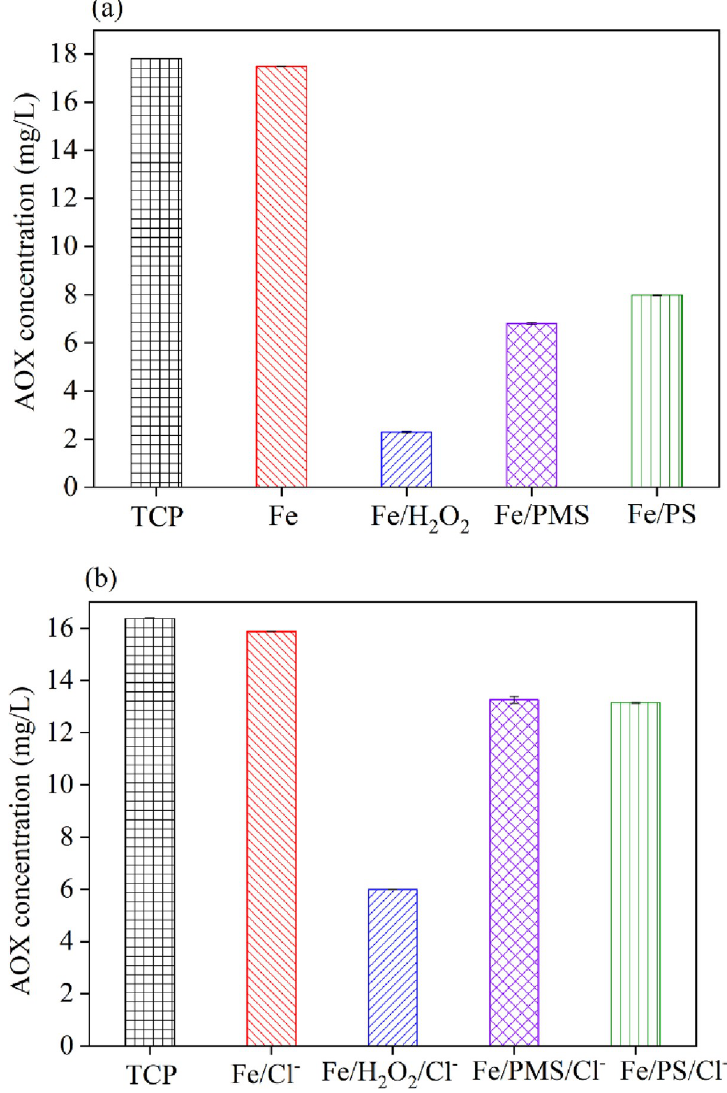
Fig 8. AOX concentration of 2,4,6-TCP degradation in four systems within 30 min. (a) without Cl - ; (b) with Cl - . Conditions: c(2,4,6-TCP) = 0.2 mmol•L -1 ; c(Ox) = 1 mmol•L -1 ; c(Fe 0 ) = 0.1 g/L; pH = 3.2 ± 0.05; c(NaCl) = 300